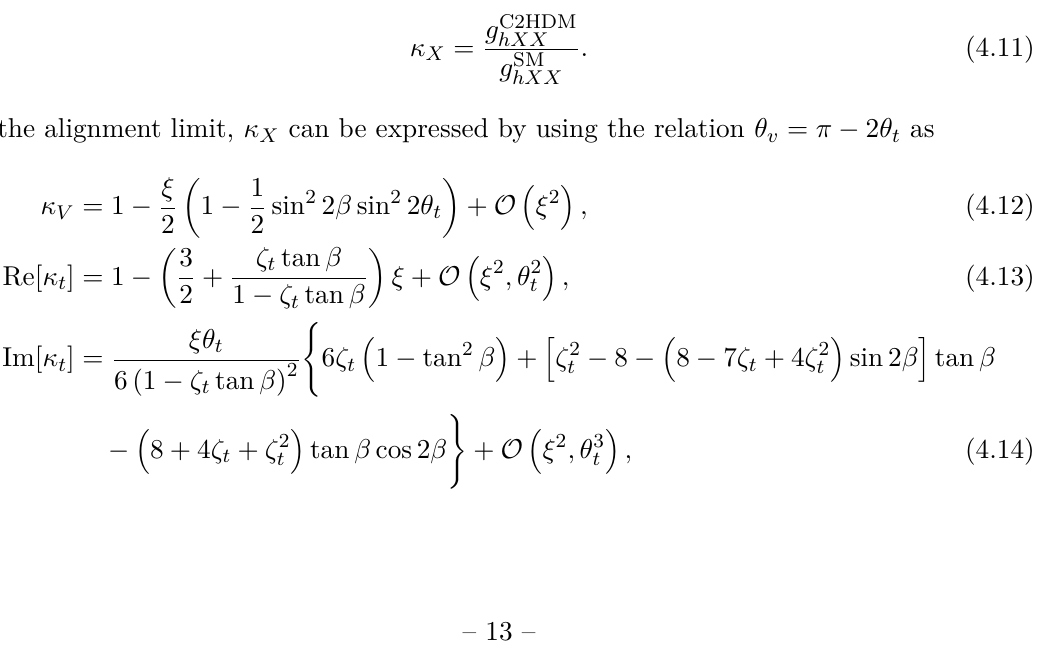
Figure 3 . Scaling factors κ θ t . The values of ζ t and ζ t tan β are also shown (top-right). The red dashed curve shows the value of ξθ t ζ t with ζ t = − 1 . 5